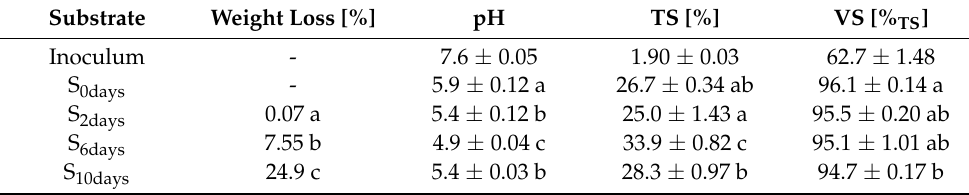
Table 3. Characterization of inoculum and substrates used for the BMP